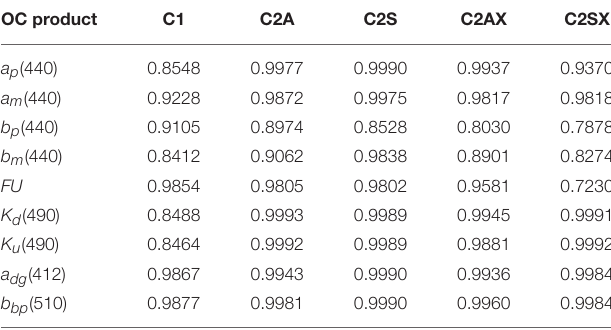
Statistics are based on N C 1 = 5392, N C 2 A = 4699, N C 2 S = 4049, N C 2 AX = 4526, and N C 2 SX =